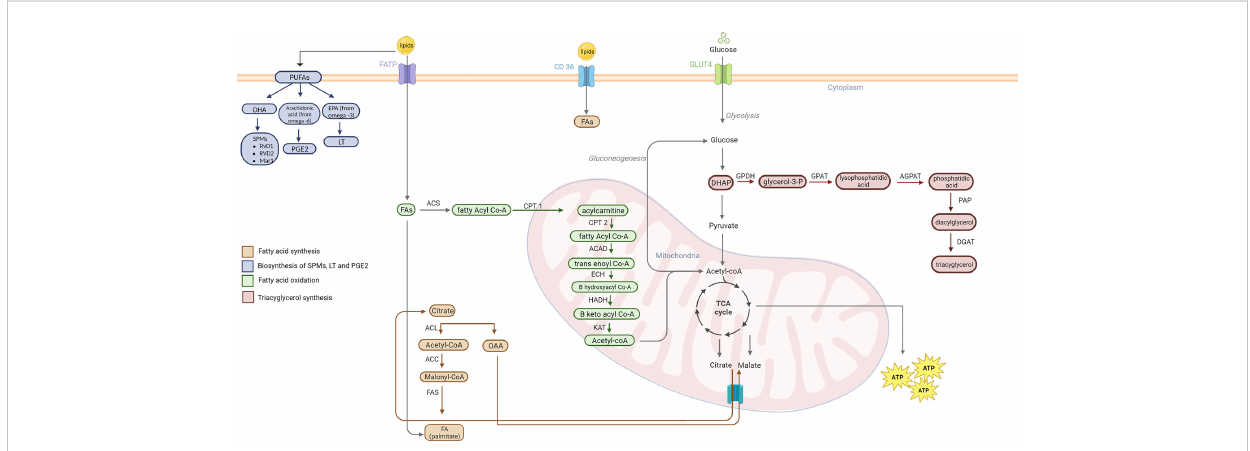
FIGURE 3 Lipid metabolism pathways. Fatty acid synthesis occurs when there is excess acetyl-CoA in the mitochondria. Acetyl Co-A combines with OAA to form citrate and is shuttled out of the mitochondria to the cytoplasm. ACL converts citrate back into acetyl-CoA. AAC activates acetyl-CoA to malonyl-CoA. FAS then combines the malonyl-CoA with another acetyl-CoA until palmitate is formed. Lipogenesis of cholesterol, phospholipids, and triacylglycerol also play a role in cancer pathogenesis. SPMs derive from DHA PUFA. EPA PUFAs from omega-3 FAs are used to create 5 series LT. Arachidonic acid from omega-6 FA are used for synthesis of PGE2. Triacylglycerol are formed from an intermediate in glycolysis, DHAP. The catabolic lipid metabolism, also called FAO, fatty acids are used to form acetyl-CoA for use in the TCA cycle. Fatty acyl-CoA is formed from FA